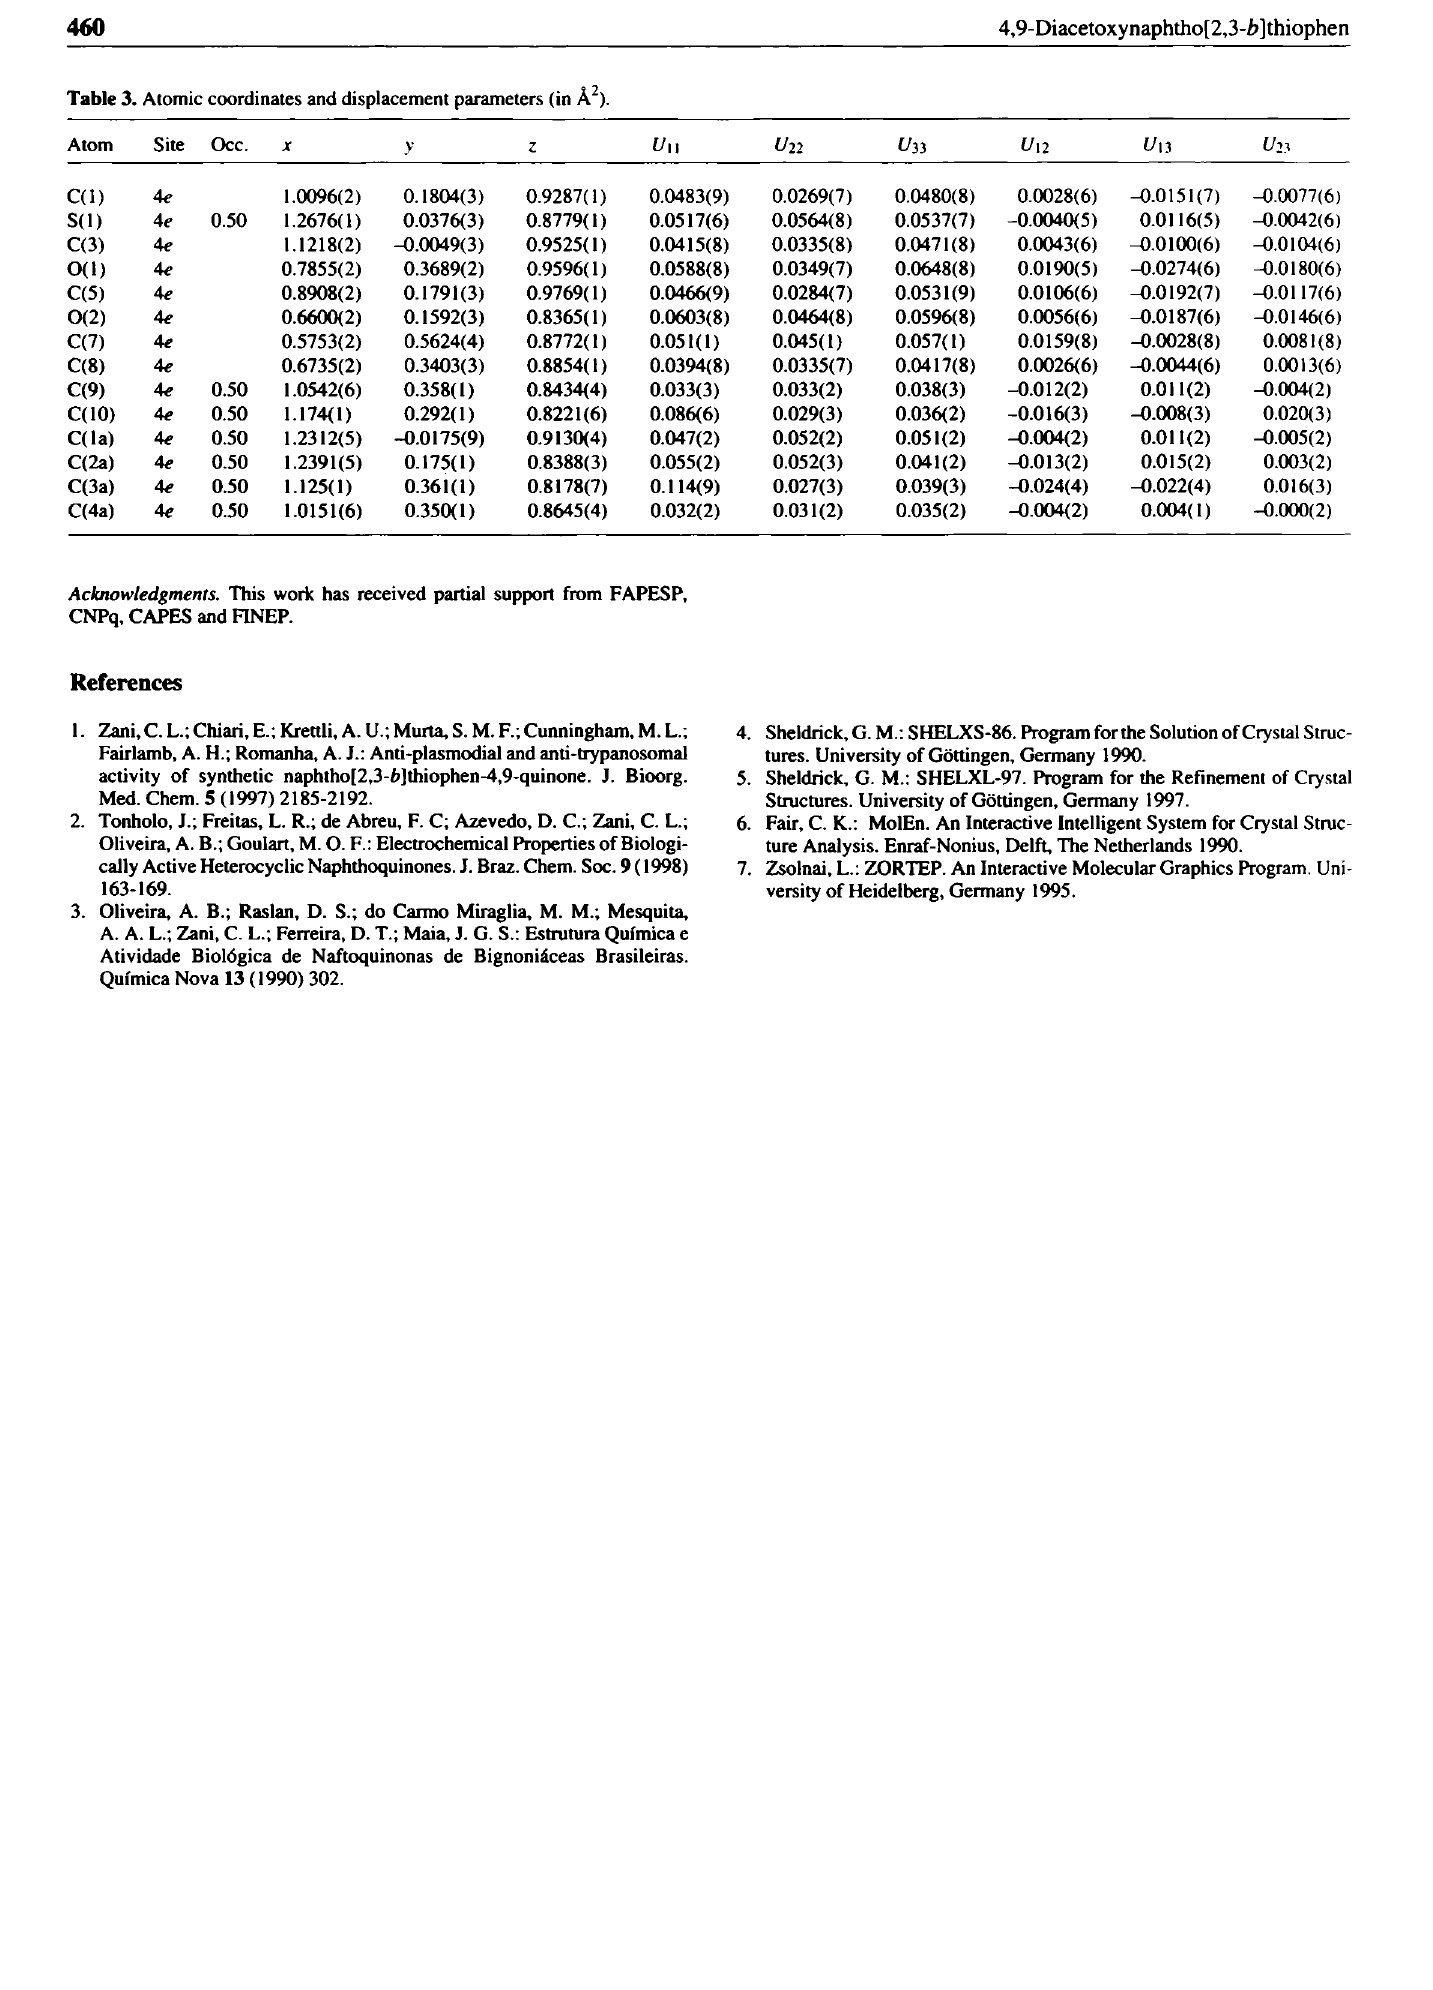
Table 3. Atomic coordinates and displacement parameters (in Ä 2